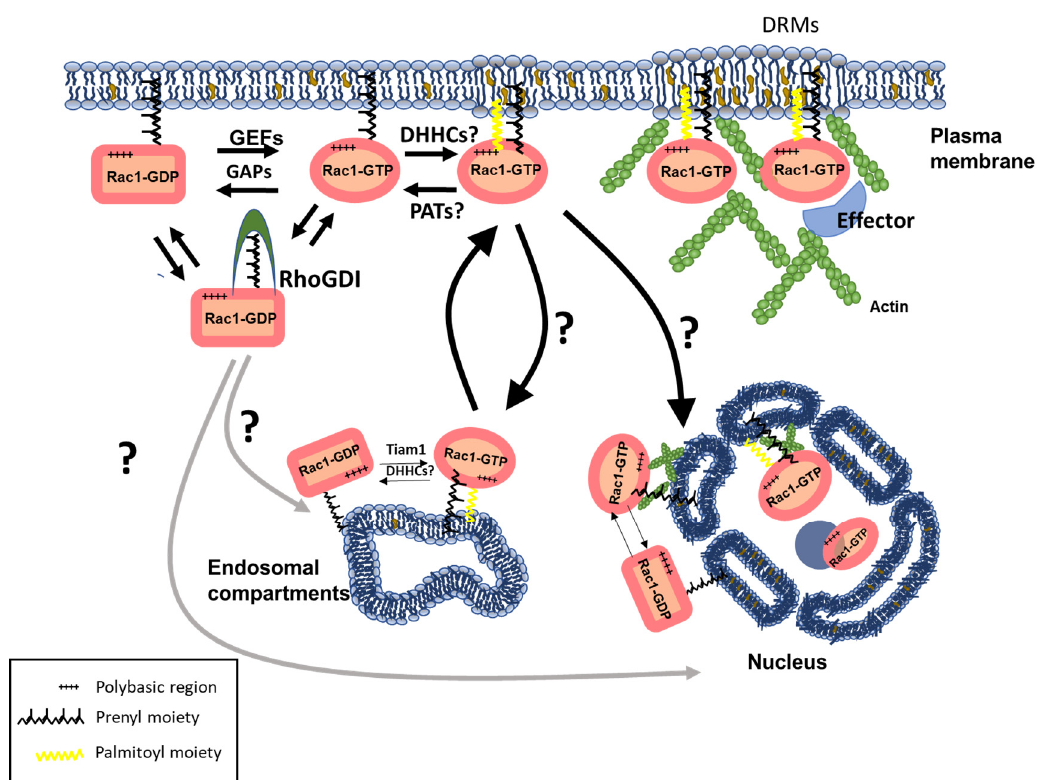
Figure 2. Rac1 trafficking: roles of lipid post-translational modifications in subcellular localization of Rho GTPases, and integration with regulatory mechanisms. The emerging, versatile code embodied by lipid modifications and the regulation they exert on subcellular sorting and activity of substrate GTPases is summarized. Specific examples are depicted here for Rac1 (DHHCs: uncharacterized palmitoyltransferase(s); PAT: uncharacterized palmitoyltransferase(s) transferring acyl chains from GTPase). Incompletely characterized steps are highlighted (?).